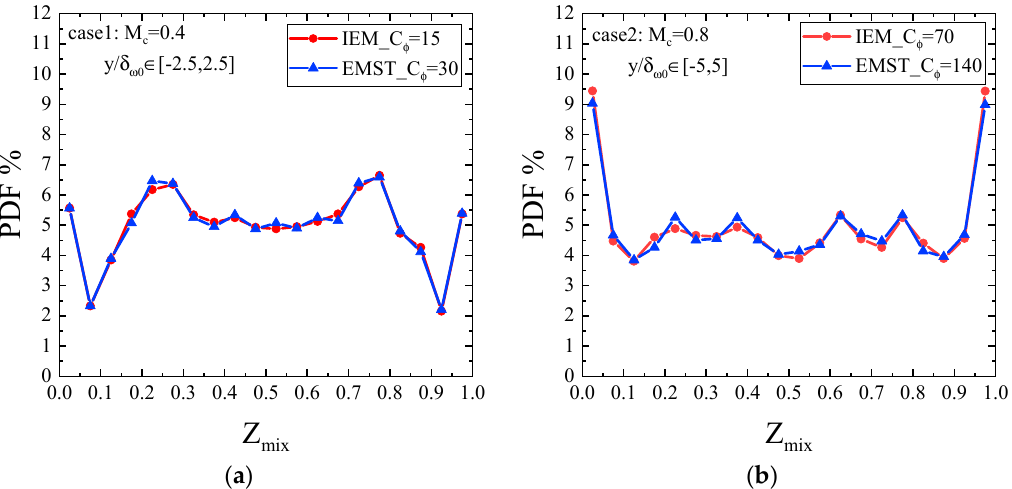
Figure 9. PDF of the mixture fraction obtained from the IEM, EMST model within the core mixing zone: ( a ) y/ δ ω 0 ∈ [ − 2.5,2.5 ] for M c = 0.4 and ( b ) y/ δ ω 0 ∈ [ − 5,5 ] for M c =